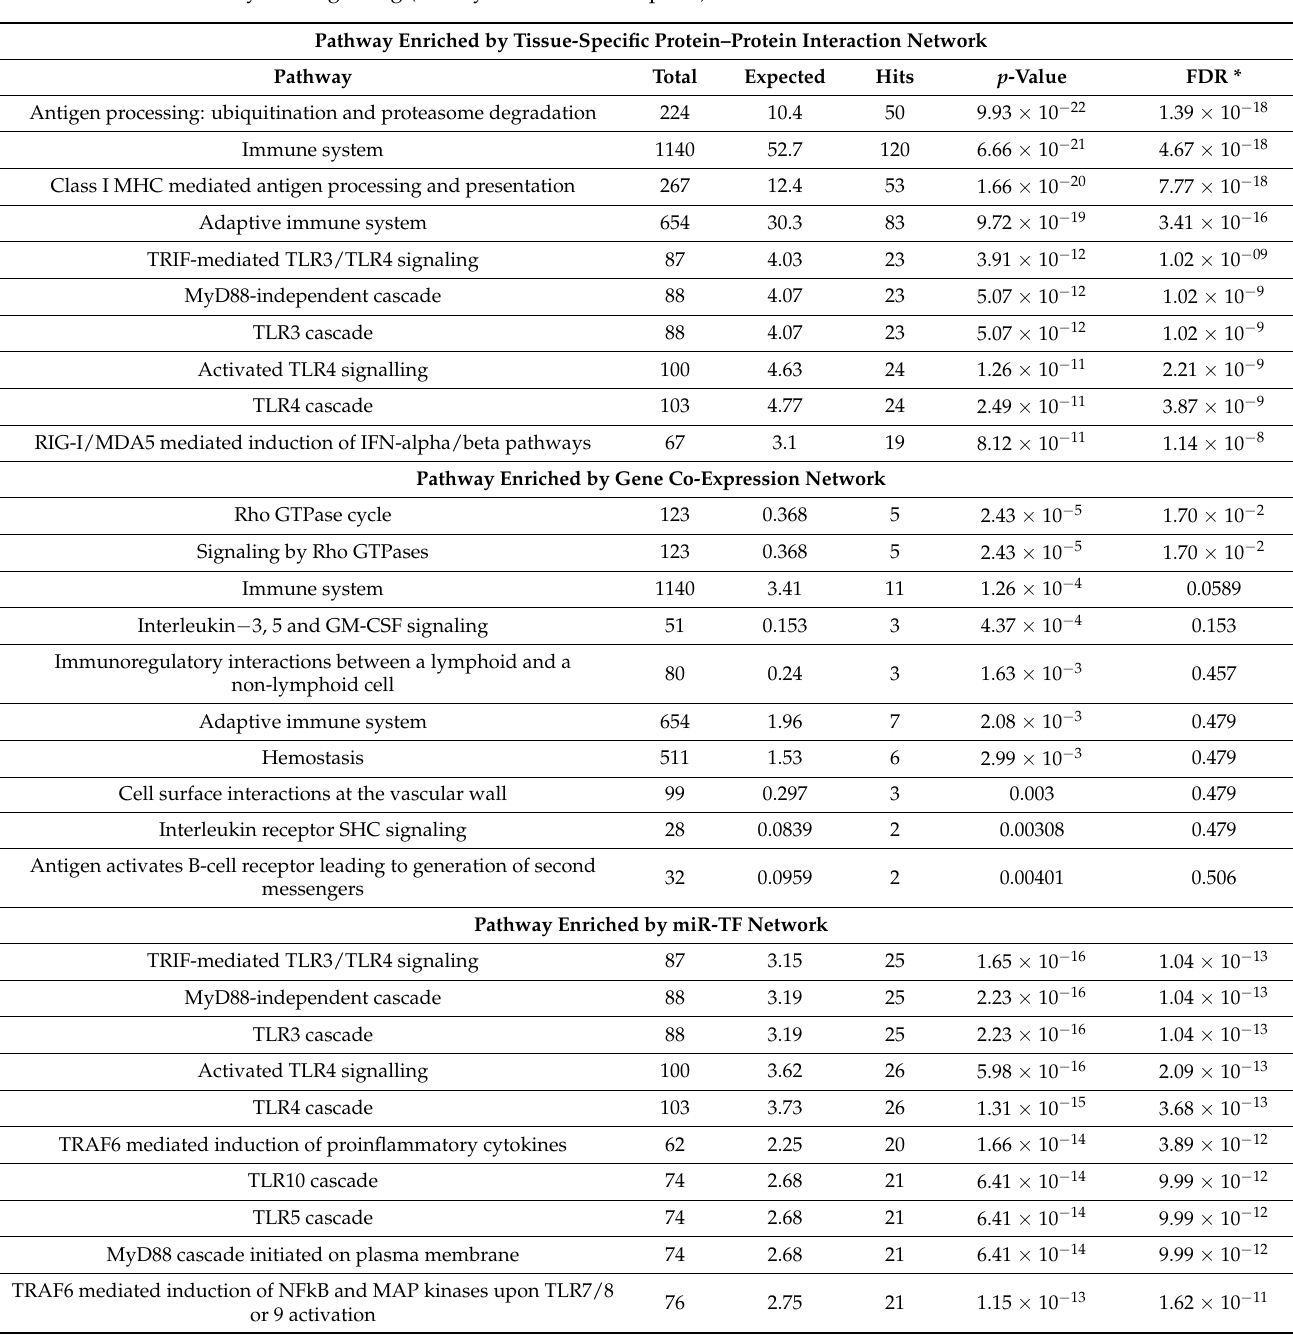
Table 4. Top enriched pathways related to tissue-specific functional sub-networks of miR-499. Each section depicts the top 10 pathways for each network. The upper section shows pathways enriched by the tissue-specific PPIN, mostly involved in antigen recognition and signaling cascade. The middle section displays pathways enriched by the tissue-specific gene co-expression network, of which the main driver nodes are involved in Rho GTPase signaling, cytokine signaling, and adaptive immune system regulation. The bottom section lists the pathways enriched by miR-TF in thyroid tissue, indicating its role in immune system signaling (mainly via toll-like receptors) cascades and inflammation